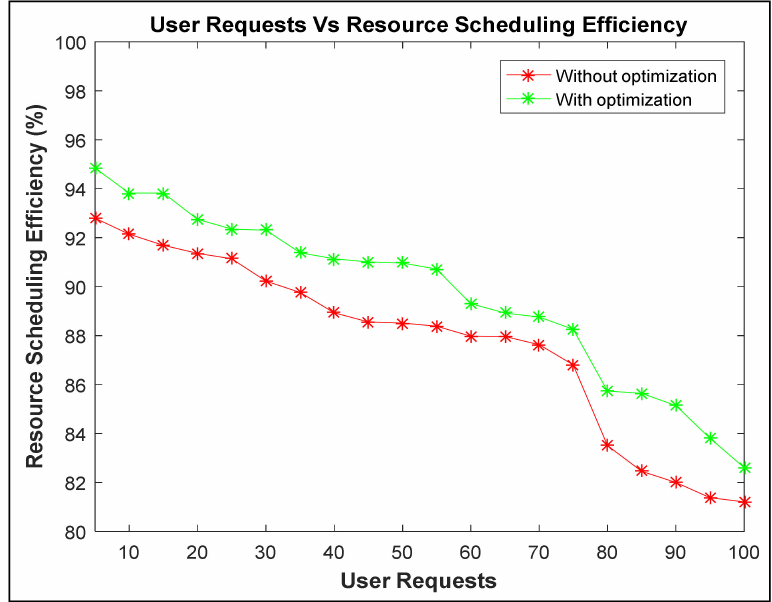
Figure 9. Resource Scheduling Efficiency.